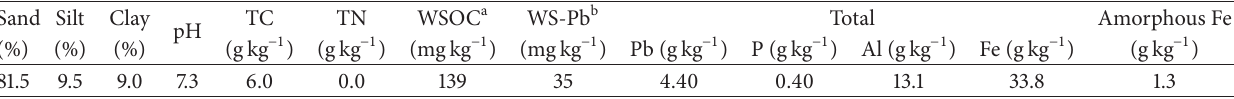
Table 1: Physicochemical properties of contaminated soil used in this study (on the basis of air-dried weight). Sand Silt Clay pH